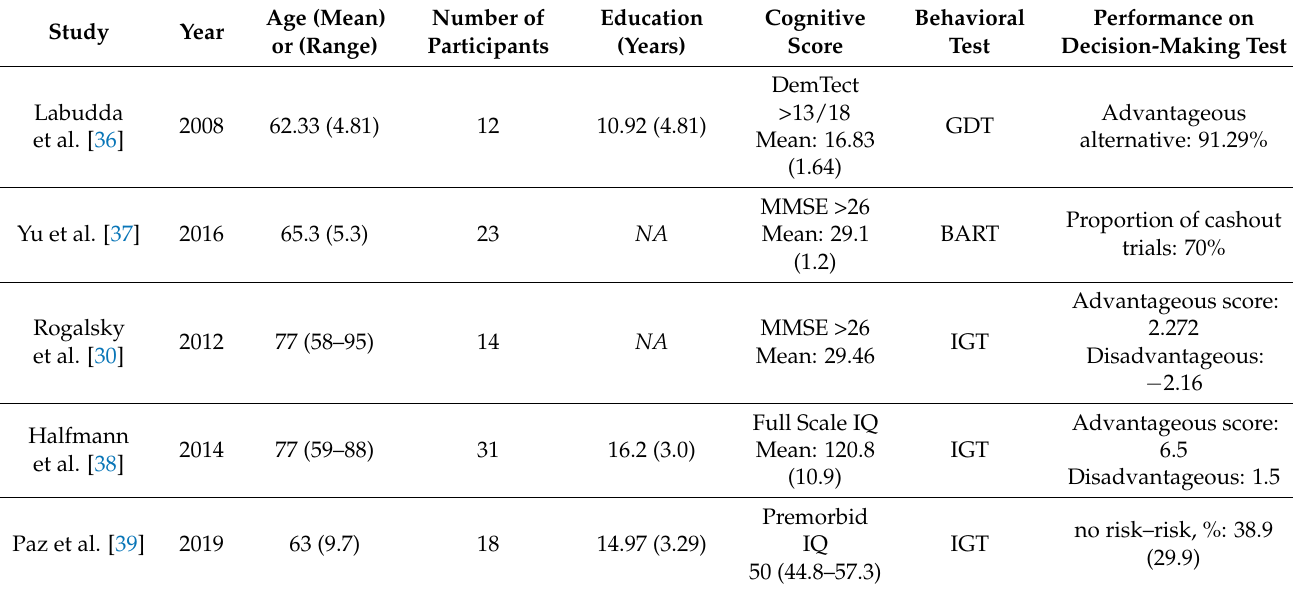
Table 1. Characteristics of the 5 included studies.